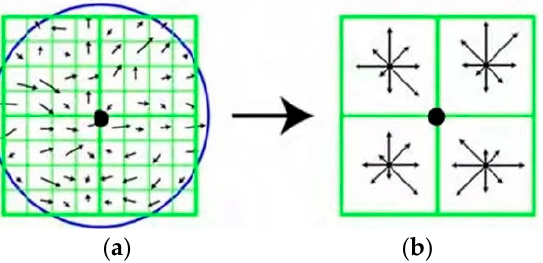
Figure 1. The feature vector of the SIFT-OCT algorithm vector. ( a ) Neighborhood gradient direction. ( b ) Key point eigenvectors.